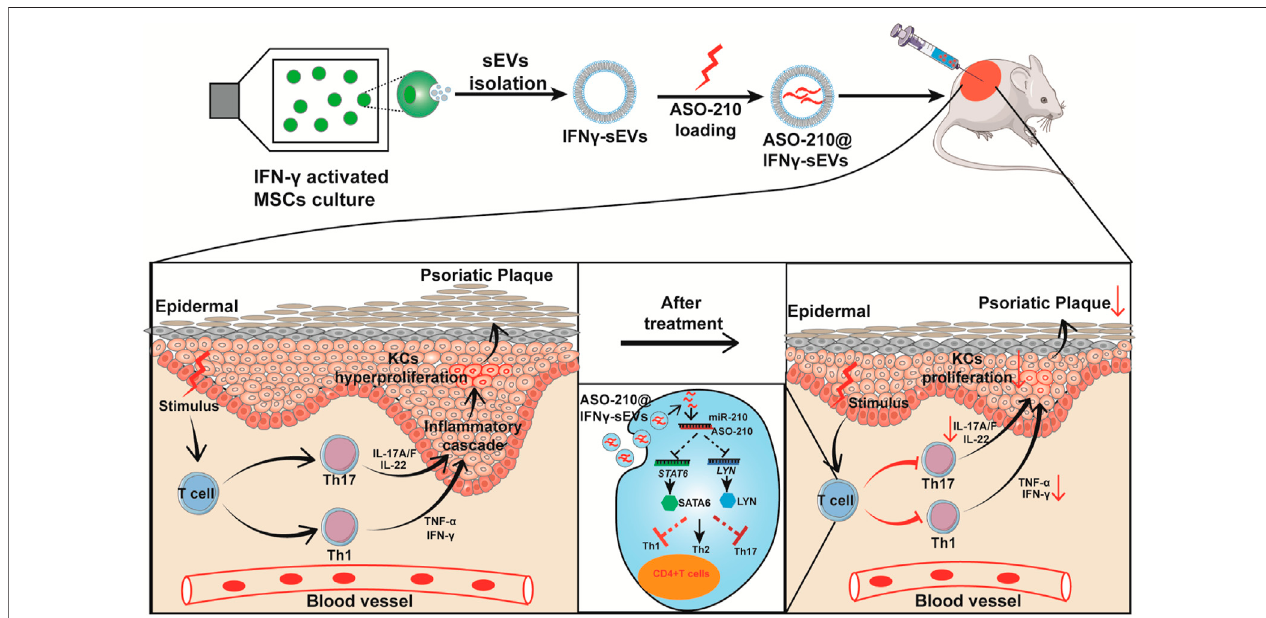
FIGURE 5 | Schematic illustrating the mechanism of ASO-210@IFN γ -sEVs alleviating the pathogenesis of psoriasis. Small extracellular vesicles were puri fi ed from the condition medium of huc-MSC stimulated with IFN- γ . ASO-210s were introduced into IFN γ -sEVs by electroporation. Then, we translated the effects of ASO-210@ IFN γ -sEVs onto a well-established IMQ-induced model to test their immunosuppressive function in vivo. ASO-210@IFN γ -sEVs, administered by intradermal injection, were mostly accumulated in the injured skin, causing a marked reduction of Th17 cell and cytokine secretion such as IL-17A, IFN- γ , TNF- α , and IL-6, and thus inhibit the proliferation of keratinocytes (KCs). These effects contribute to alleviate the formation of psoriatic skin lesions.